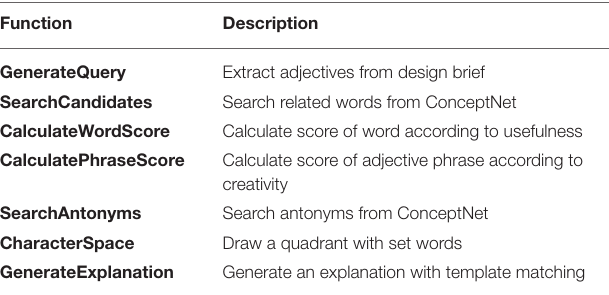
TABLE 1 | List of functions in CSC